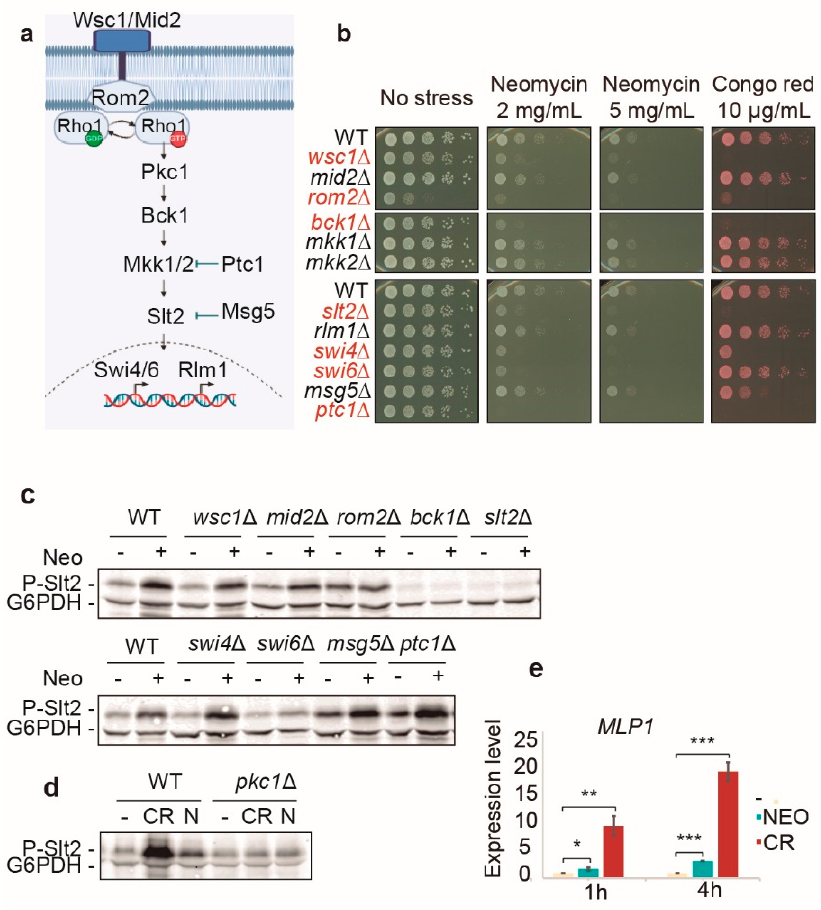
Figure 4. The CWI pathway is essential for yeast cells to survive in the presence of neomycin. ( a ) Scheme depicting the main components of the CWI pathway. ( b ) Sensitivity to neomycin of isogenic Y3656 mutants lacking the indicated CWI pathway components was assayed by spotting 10-fold serial dilutions of cell suspensions onto YPD plates in the absence (no stress) or presence of either 2 or 5 mg/mL neomycin or 10 µ g/mL of CR. Red letters indicate higher sensitivity to neomycin than the wild-type strain. A representative assay from three different experiments is shown. ( c ) Neomycin-elicited signaling to Slt2 is mediated by core components of the CWI pathway. Western blotting analysis of extracts of isogenic Y3656 mutants lacking the indicated CWI pathway components treated (+) or not ( − ) for 4 h with 10 mg/mL neomycin. ( d ) Western blotting analysis of CML128 (WT) and pkc1 ∆ mutant isogenic strains in the absence ( − ) or presence of 30 µ g/mL CR or 10 mg/mL neomycin (N) for 4 h. Dually phosphorylated Slt2 and G6PDH (as a loading control) were detected with anti-phospho-p44/42 and anti-G6PDH antibodies, respectively. A representative blot from three independent experiments is displayed. ( e ) Neomycin induces Rlm1-mediated gene transcription. Transcriptional induction analysis of the MLP1 gene by RT-qPCR in response to neomycin compared to CR in the Y3656 strain. Cells were cultured in the absence of stress ( − ) or with 10 mg/mL neomycin or 30 µ g/mL CR for 1 or 4 h. The graph shows the mean and standard deviation of the expression level from three independent experiments. Asterisks indicate statistical significance relative to the absence of stress according to a Student’s t -test (* = p -value < 0.05; ** = p -value < 0.01; *** = p -value < 0.001).